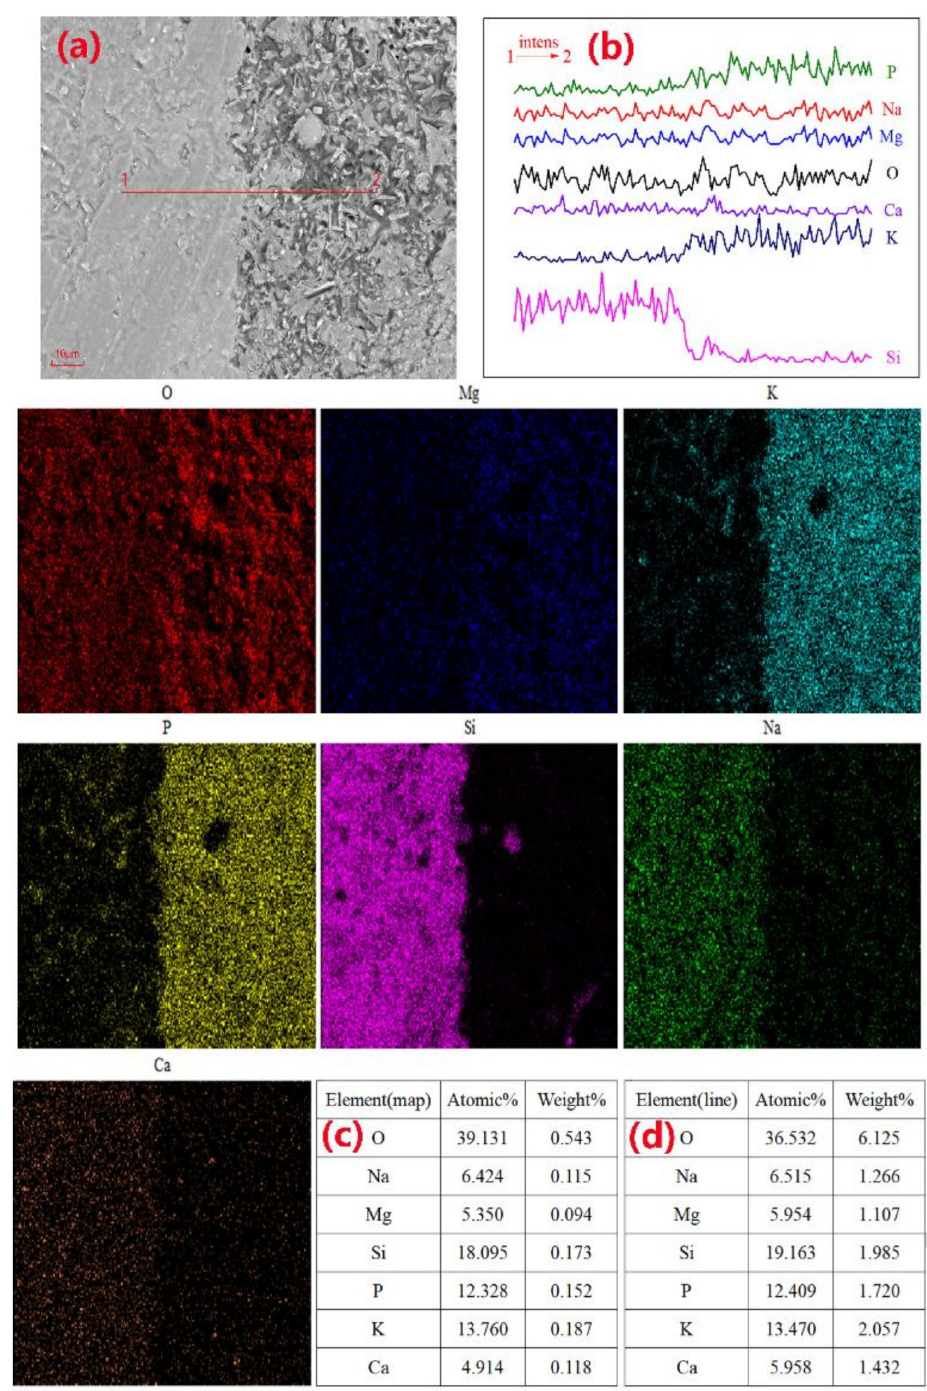
Figure 12. SEM images and elemental maps along lines 1–2 of the MKPC pastes cured after 7 days: M/P ratio = 1:1 and 40 wt.% content of glass fragments, ( a ) SEM image; ( b ) Intensity of each element distribution along line 1-2; ( c ) EDS elemental distribution along lines 1–2; ( d ) EDS elemental